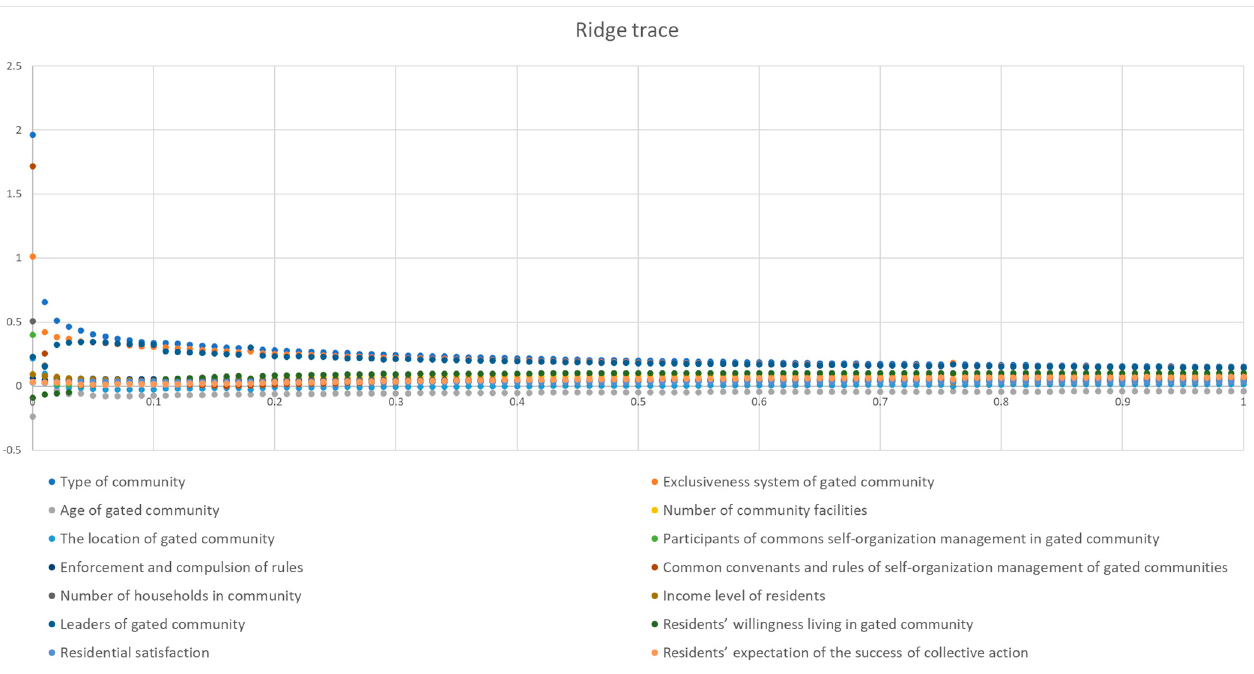
Figure 7. Ridge trace.